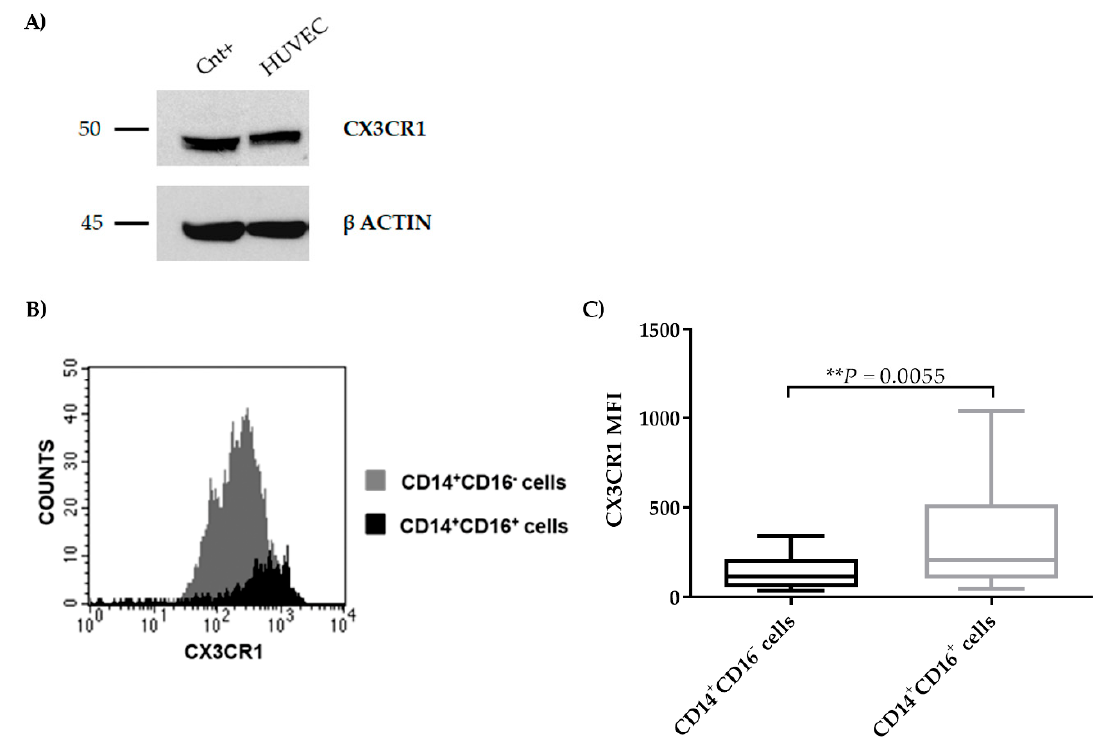
Figure 5. CX3CR1 expression by ECs. ( A ) Protein expression of CX3CR1 was evaluated by western blot on HUVEC cells (positive control: THP-1 cells). ( B ) The flow-cytometry histogram shows CX3CR1 expression and median fluorescence intensity (MFI) of CD14 + CD16 + (black) and CD14 + CD16 − (grey) monocyte subsets in one representative Multiple Myeloma patient (MM)-68. ( C ) Box plots represent the median level of CX3CR1 MFI in BM CD14 + CD16 + and CD14 + CD16 − monocytes from 2 MGUS,